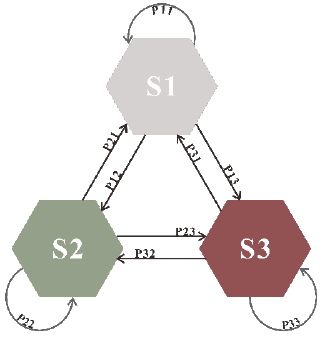
Figure 7. Schematic diagram of the Markov chain.